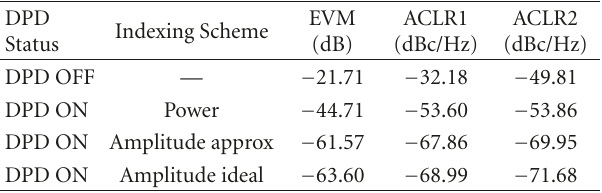
A linearly interpolated complex-gain LUT with 64 entries was used to predistort the class-E amplifier. A WCDMA rel. 8 HSUPA-compliant 64QAM signal, with > 6.5 dB composite PAPR is used as input. The input signal (I/Q) resolution was set to 13 bits and a 3 dB backo ff was selected. The EVM and adjacent channel leakage ratios (ACLRs) at 5 MHz o ff set (ACLR1) and 10 MHz o ff set (ACLR2) are shown in Table 2. The ACLR1 and ACLR2 are measured in dBc across a 5 MHz channel bandwidth. The EVM resulting from the use of the amplitude indexing is nearly 17 dB lower than that of the power indexing, and only 2 dB higher than that of the ideal amplitude indexing. The ACLR1 and ACLR2 measurements show more than 14 dB improvement when using the amplitude approximation instead of the power indexing. Figure 4 shows the WCDMA power spectral density (PSD) resulting from the above experiment. It is observed that the spectral regrowth is e ff ectively reduced by the predistorters. The higher spectral floor resulting from the power indexing scheme indicates its relatively strong sensitivity to LUT quantization